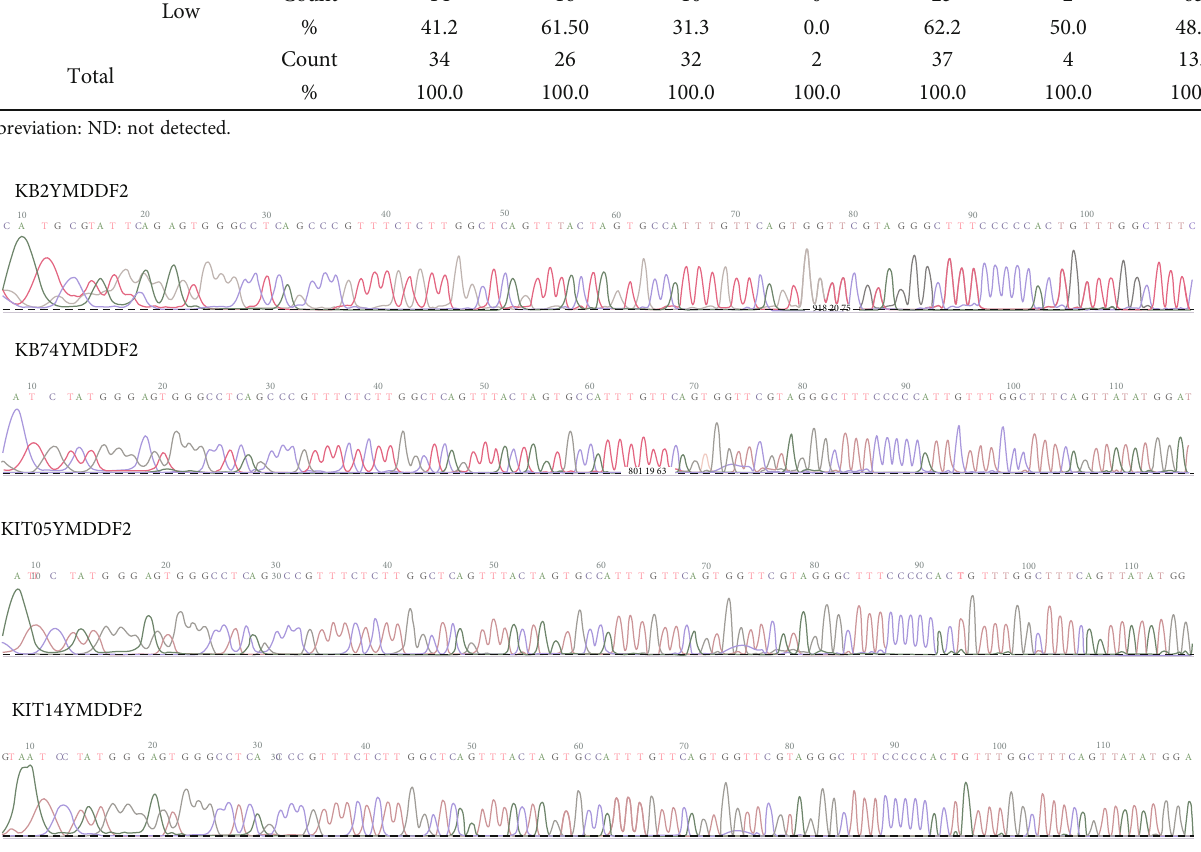
Figure 2: Graphs showing FASTA format sequences with the corresponding chromatograms from BioEdit for representative sequences KB2YMMDF2, KB74YMMDF2 (for Kibuku), KIT05YMMDF2, and KIT14YMMDF2 (for